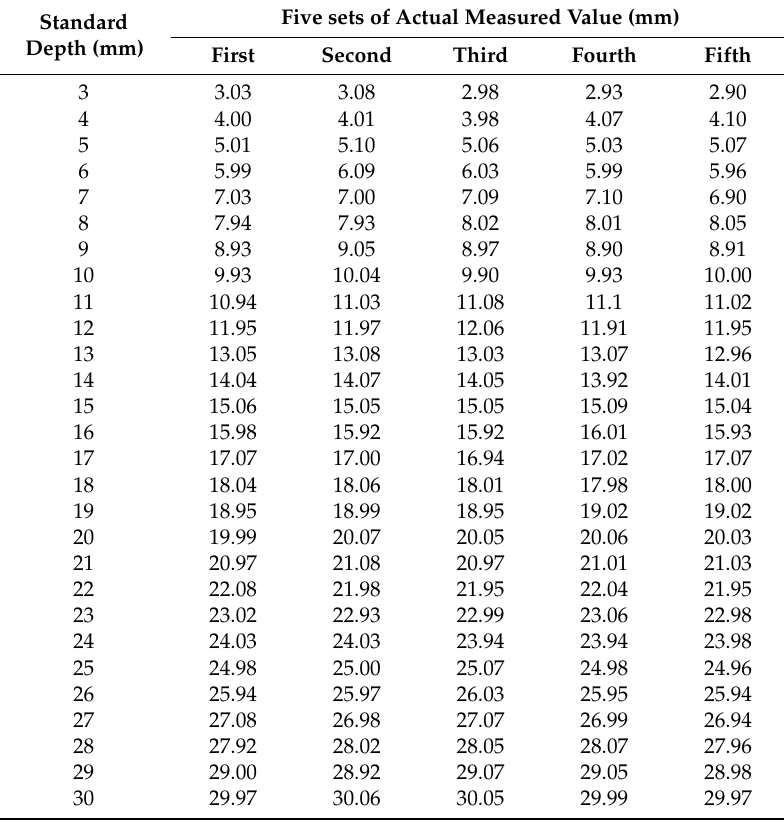
Table 1. Experimental data for measurement accuracy and repeatability verification.